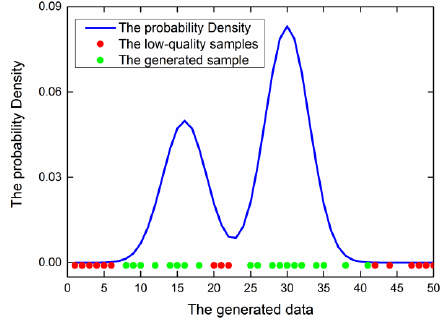
Figure 5. The low ‐ quality samples in actual situations.